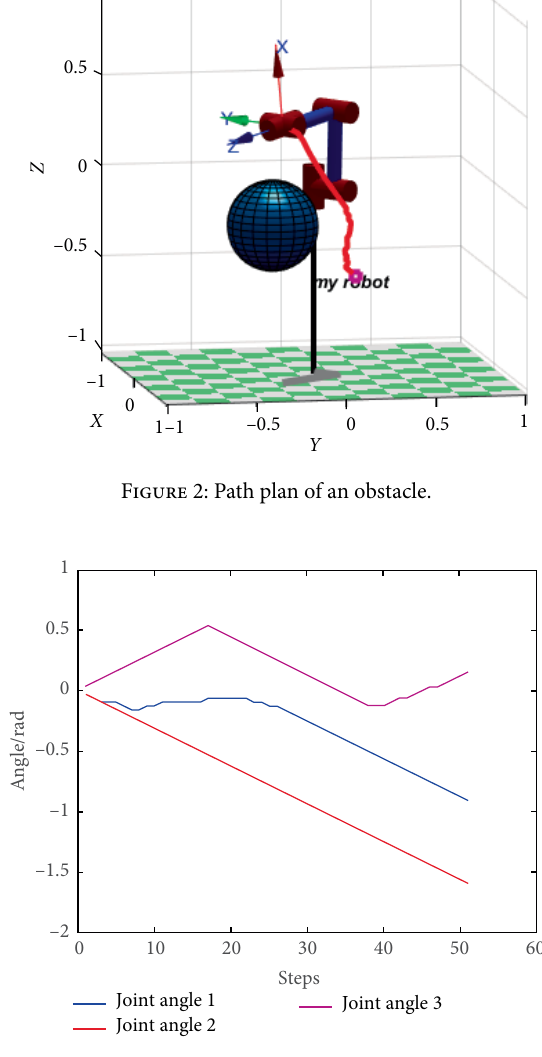
Figure 3: Changes in the joint angle of each.